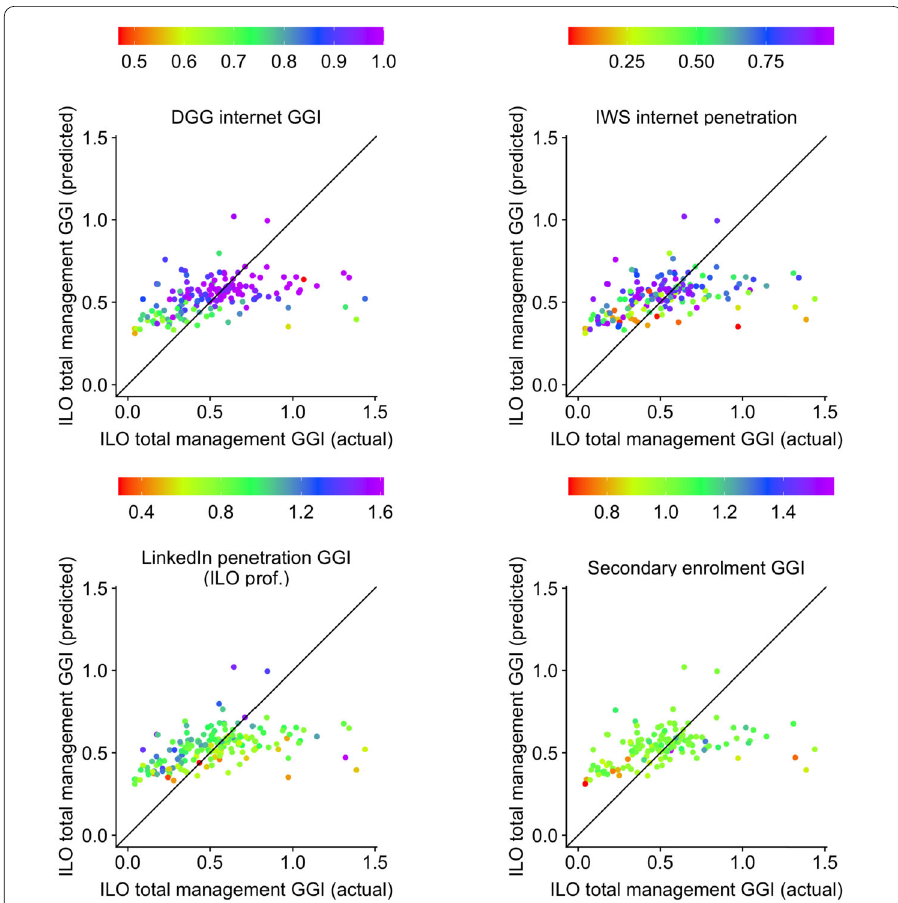
Figure 8 Scatter plot of ILO total management GGI (actual) ( x -axis) and ILO total management GGI (predicted) y -axis). Points in each panel are colour coded by values of the variable listed